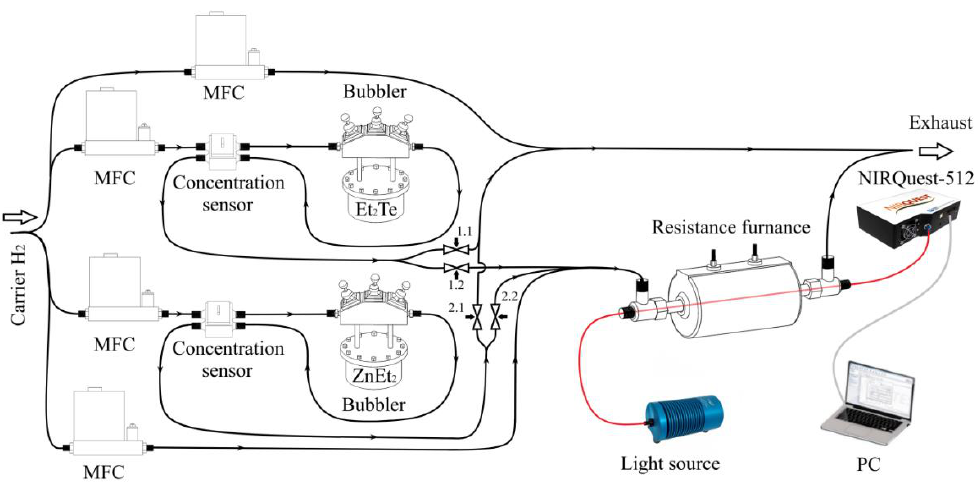
Figure 1. The scheme of deposition of ZnTe films on the lateral surface of an optical fiber by the MOCVD method with parallel control of the transmission spectra of a dielectric light guide.